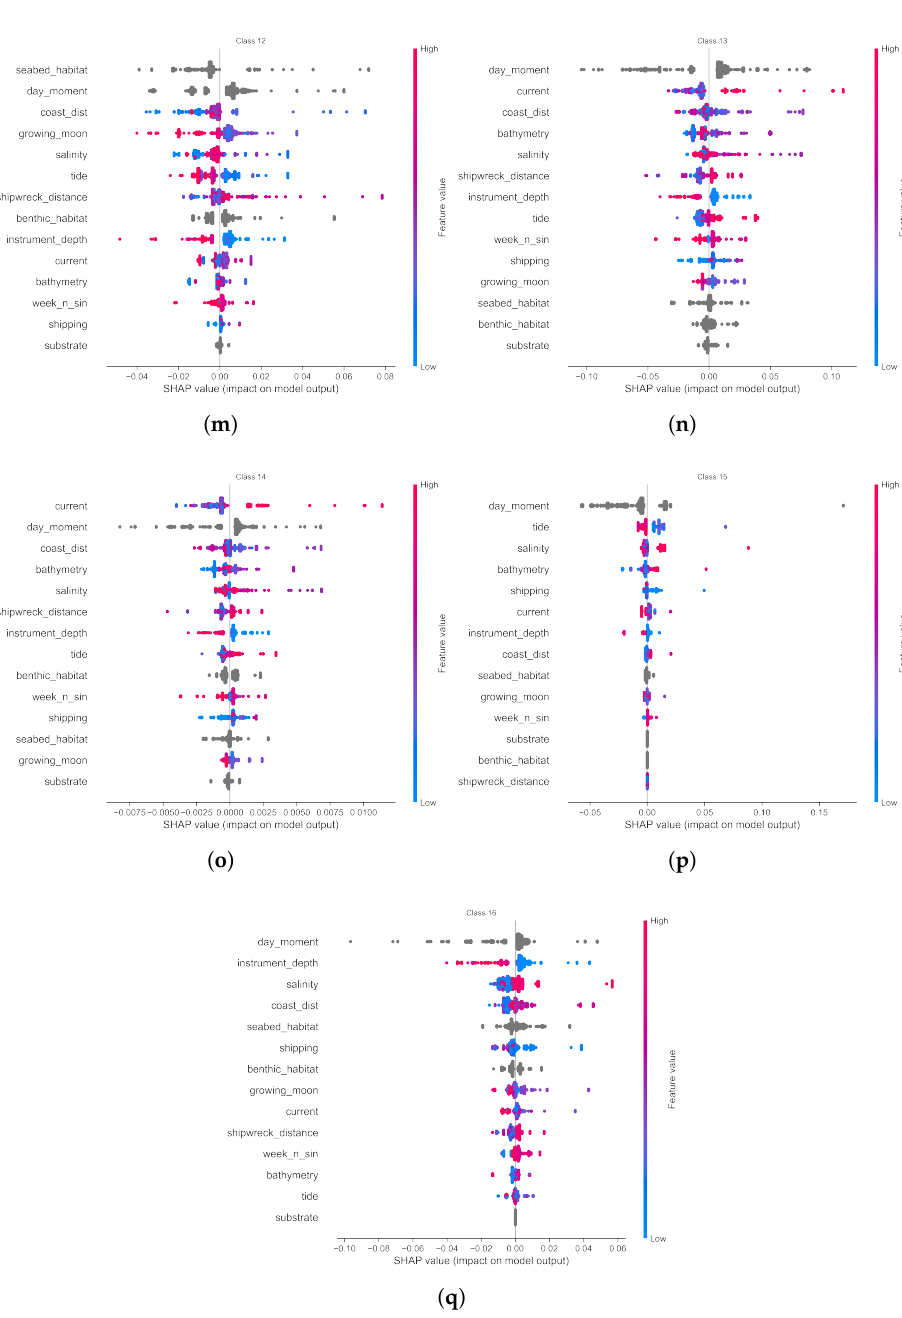
Figure A1. Summary of the SHAP values for all the features for class: ( a ) 0 ( b ) 1 ( c ) 2 ( d ) 3 ( e ) 4 ( f )